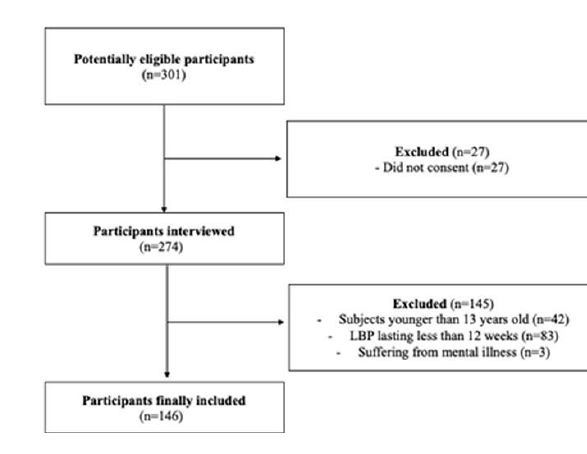
Figure 1 : Flow diagram of sample selection. LBP: Low back